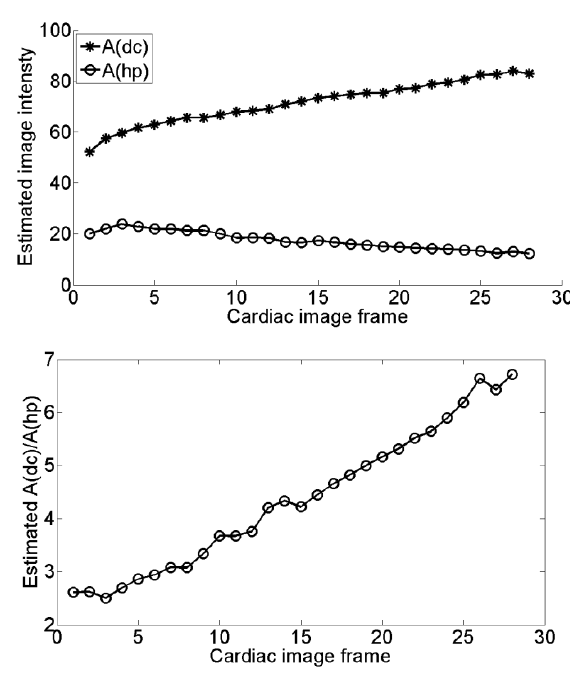
and A , Bottom: Estimated intensity ratio dc hp